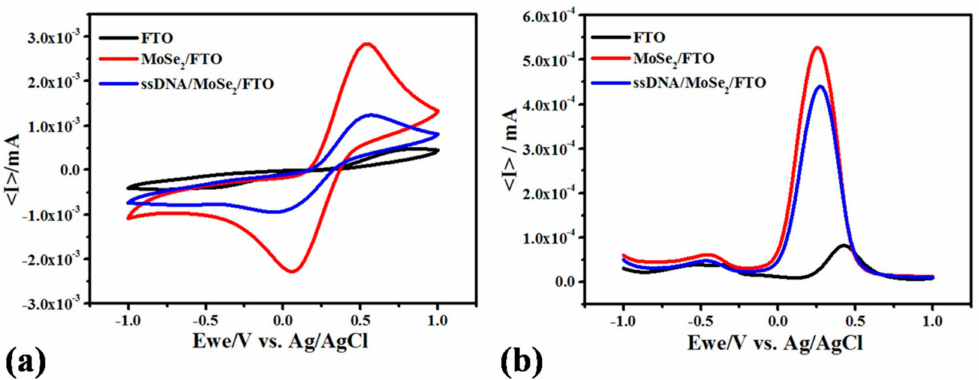
Figure 2. ( a ) Cyclic Voltammogram and ( b ) Differential Pulse Voltammogram of fluorine doped tin oxide (FTO), MoSe 2 /FTO and ssDNA/MoSe 2 /FTO conducted in 1 µ M MB (pH 7.4) in 0.1 M KCl at the scan rate of 100 mV/s.